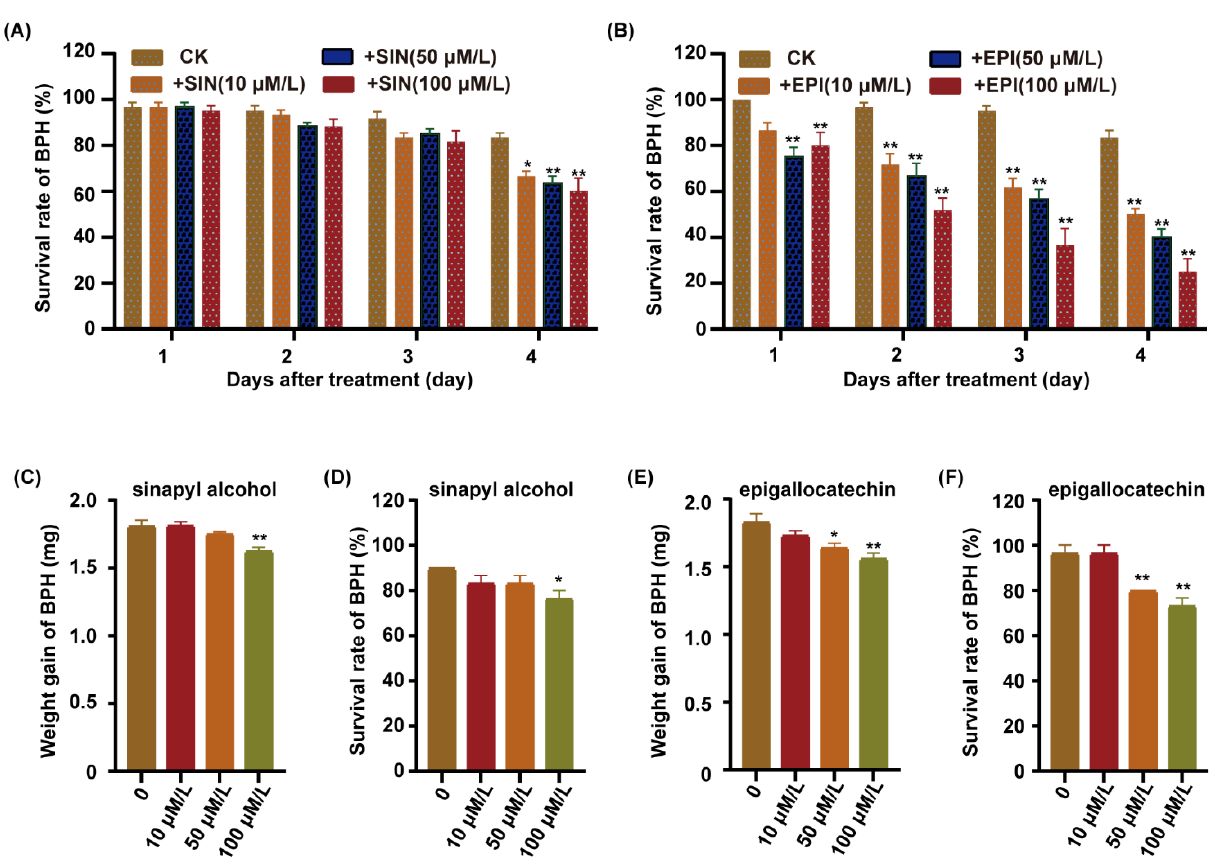
Figure 7. Functional validation of candidate metabolites. ( A ) Survival rate of BPH fed on artificial diet supplemented with different concentrations of sinapyl alcohol. ( B ) Survival rate of BPH fed on artificial diet supplemented with different concentrations of epigallocatechin. ( C ) Weight gain of BPH fed on Nipponbare plants pre-treatment with sinapyl alcohol applied to 1/2 MS at concentrations of 0 µM/L, 10 µM/L, 50 µM/L or 100 µM/L for 7 days, followed by female BPH adult infestation for 48 h. ( D ) Survival rate of BPH fed on Nipponbare plants pre-treatment with sinapyl alcohol applied to 1/2 MS at concentrations of 0 µM/L, 10 µM/L, 50 µM/L or 100 µM/L for 7 days, followed by female BPH adult infestation for 48 h. ( E ) Weight gain of BPH fed on Nipponbare plants pre-treatment with epigallocatechin applied to 1/2 MS at concentrations of 0 µM/L, 10 µM/L, 50 µM/L or 100 µM/L for 7 days, followed by female BPH adult infestation for 48 h. ( F ) Survival rate of BPH fed on Nipponbare plants pre-treatment with epigallocatechin applied to 1/2 MS at concentrations of 0 µM/L, 10 µM/L, 50 µM/L or 100 µM/L for 7 days, followed by female BPH adult infestation for 48 h. Error bars, mean ± SE of 6 biological replicates ( A , B ) or three replicates ( C – F ), The asterisk represent a significant difference between the treatment and the control. *, p < 0.05; **, p < 0.01 by one-way ANOVA with Dunnett’s post-hoc test. All data are presented as the mean value ± SE.